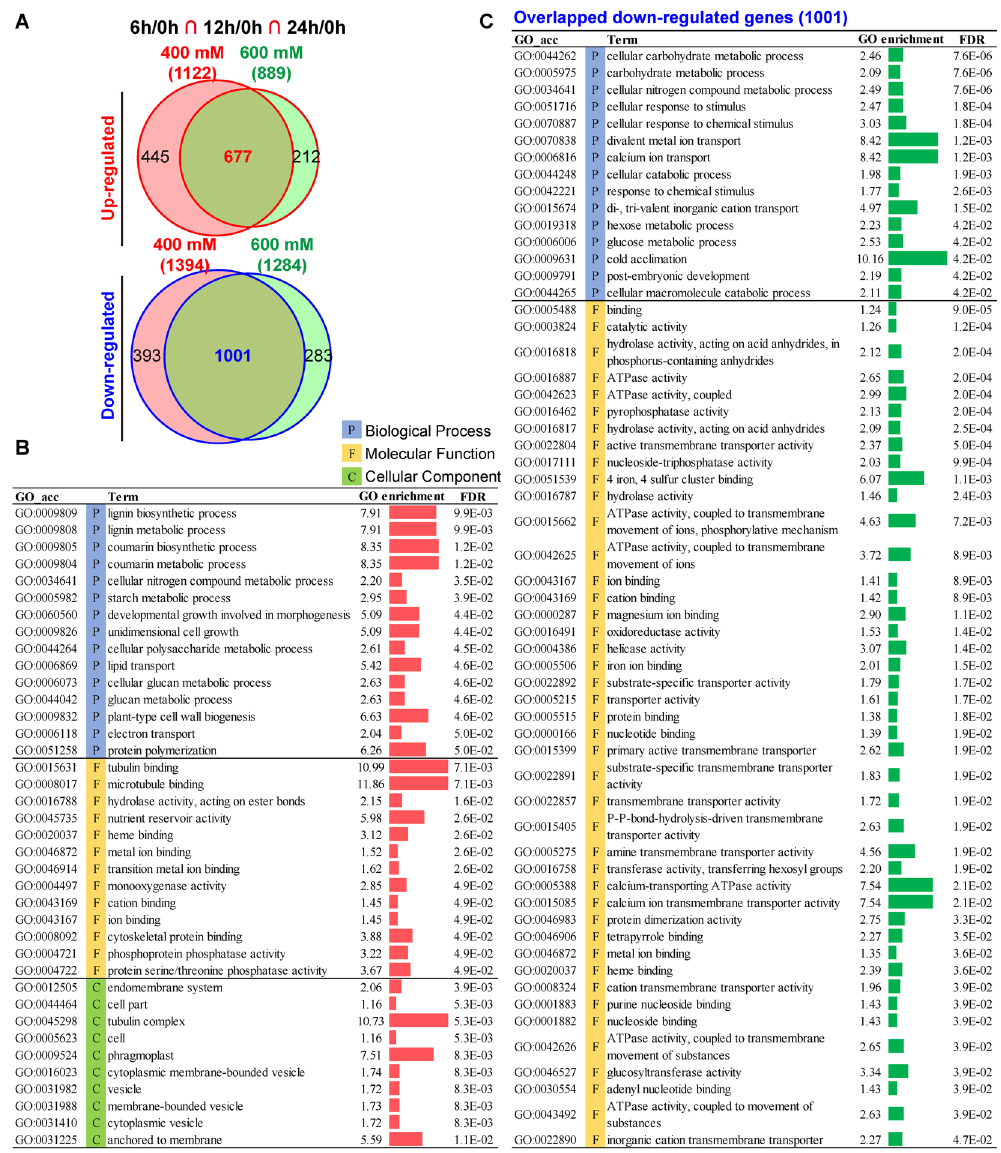
Figure 3. GO enrichment of up- or down-regulated core genes in P . euphratica after both 400 mM and 600 mM NaCl treatments. ( A ) Overlap of up- or down-regulated core genes in Fig. 2A between 400 mM and 600 mM NaCl treatments. ( B ) GO enrichment of 677 up-regulated core genes in both 400 mM and 600 mM NaCl treatments. ( C ) GO enrichment of 1001 down-regulated core genes in both 400 mM and 600 mM NaCl